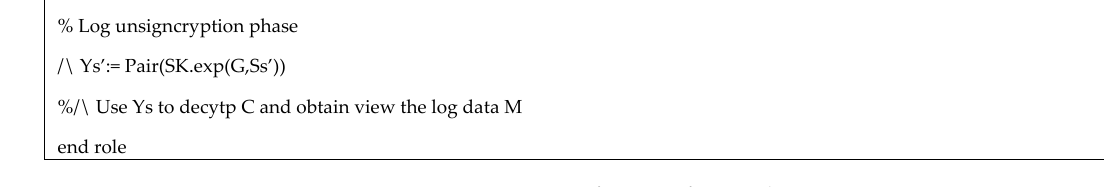
Figure 3. HLPLS specification of user role.